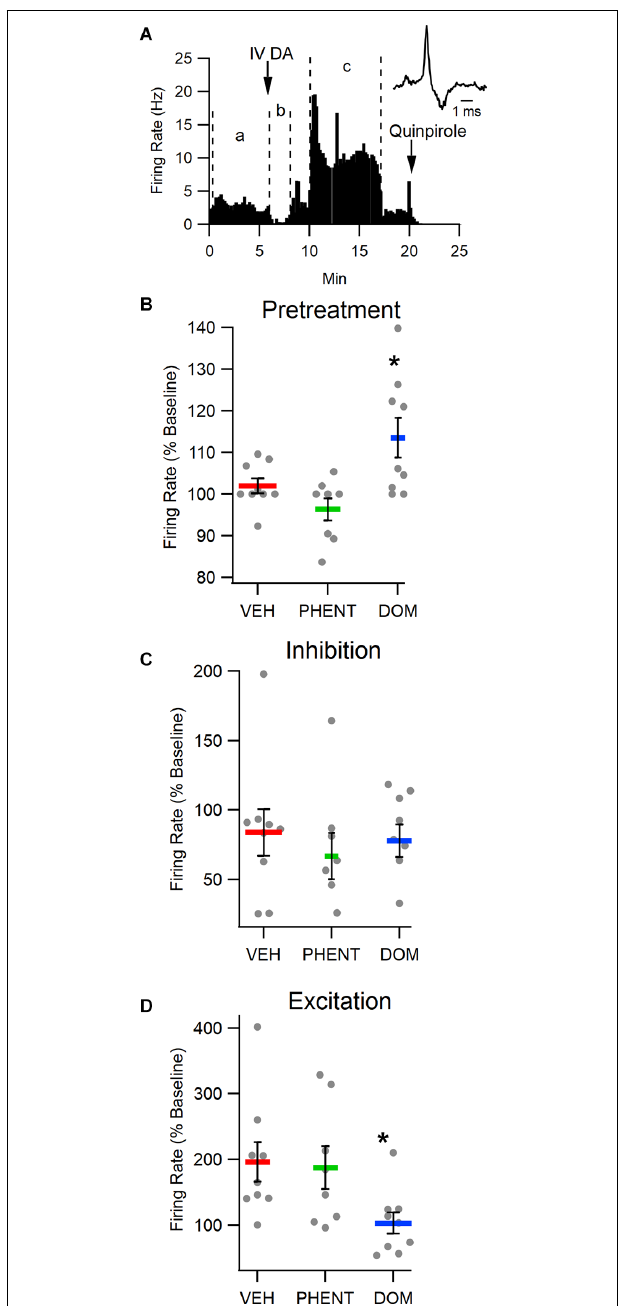
FIGURE 3 | Intravenous DA enhances the firing rate of putative DA neurons in the VTA. (A) Representative trace of the firing rate of a putative DA neuron in an experiment in which IV DA was administered. Note the transient, inhibition from baseline (between lines marked in a) of firing rate immediately after the injection (between lines marked b) and the more prolonged increase in firing rate following the transient inhibition (between lines marked c). (B) The firing rate of putative DA neurons was enhanced by domperidone (DOM; 1 mg/kg, IV) pretreatment. (C) The magnitude of inhibition produced by IV DA (3.0 mg/kg, IV) administration was not affected by pretreatment with vehicle (VEH), phentolamine (PHENT), or DOM. (D) However, DOM blocked the enhancement of the DA neuron firing rate produced by IV DA. Phentolamine did not significantly decrease this effect. * indicates p <